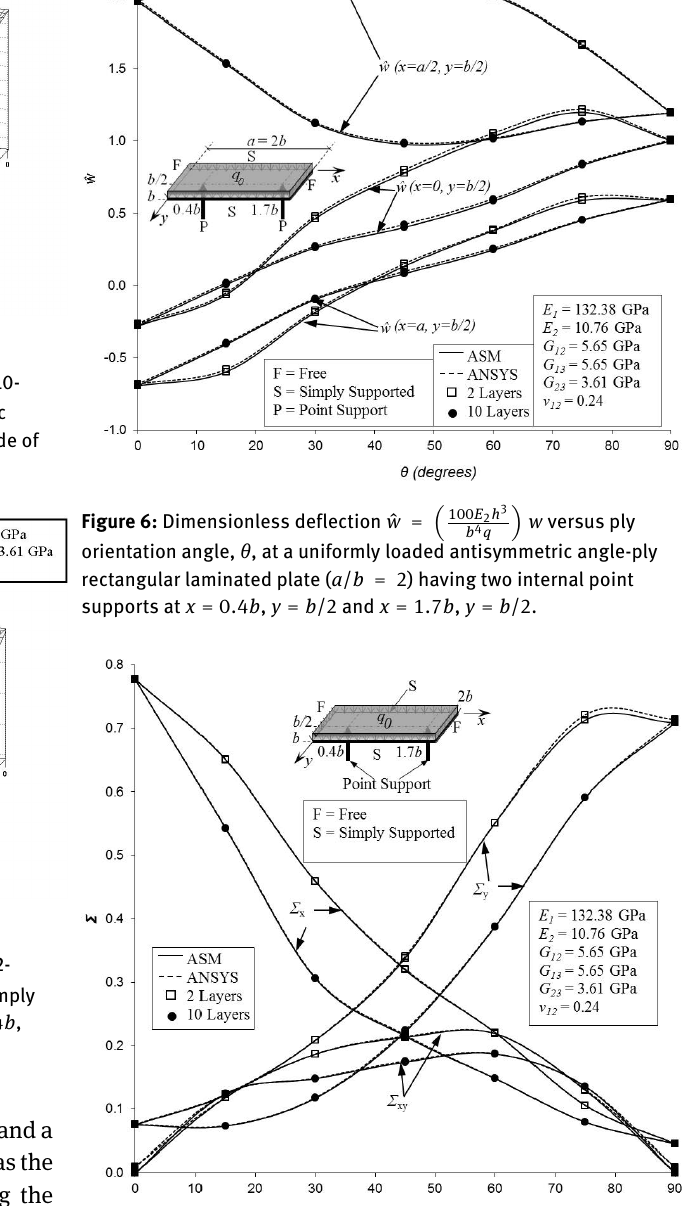
Figure 7: Dimensionless stresses, Σ orientation angle, θ , for a uniformly loaded antisymmetric angle- ply rectangular laminated plate ( a / b = 2) having two internal point supports at x = 0.4 b , y = b /2 and x = 1.7 b , y = b /2 , and simply supported at y = 0 and y = a .